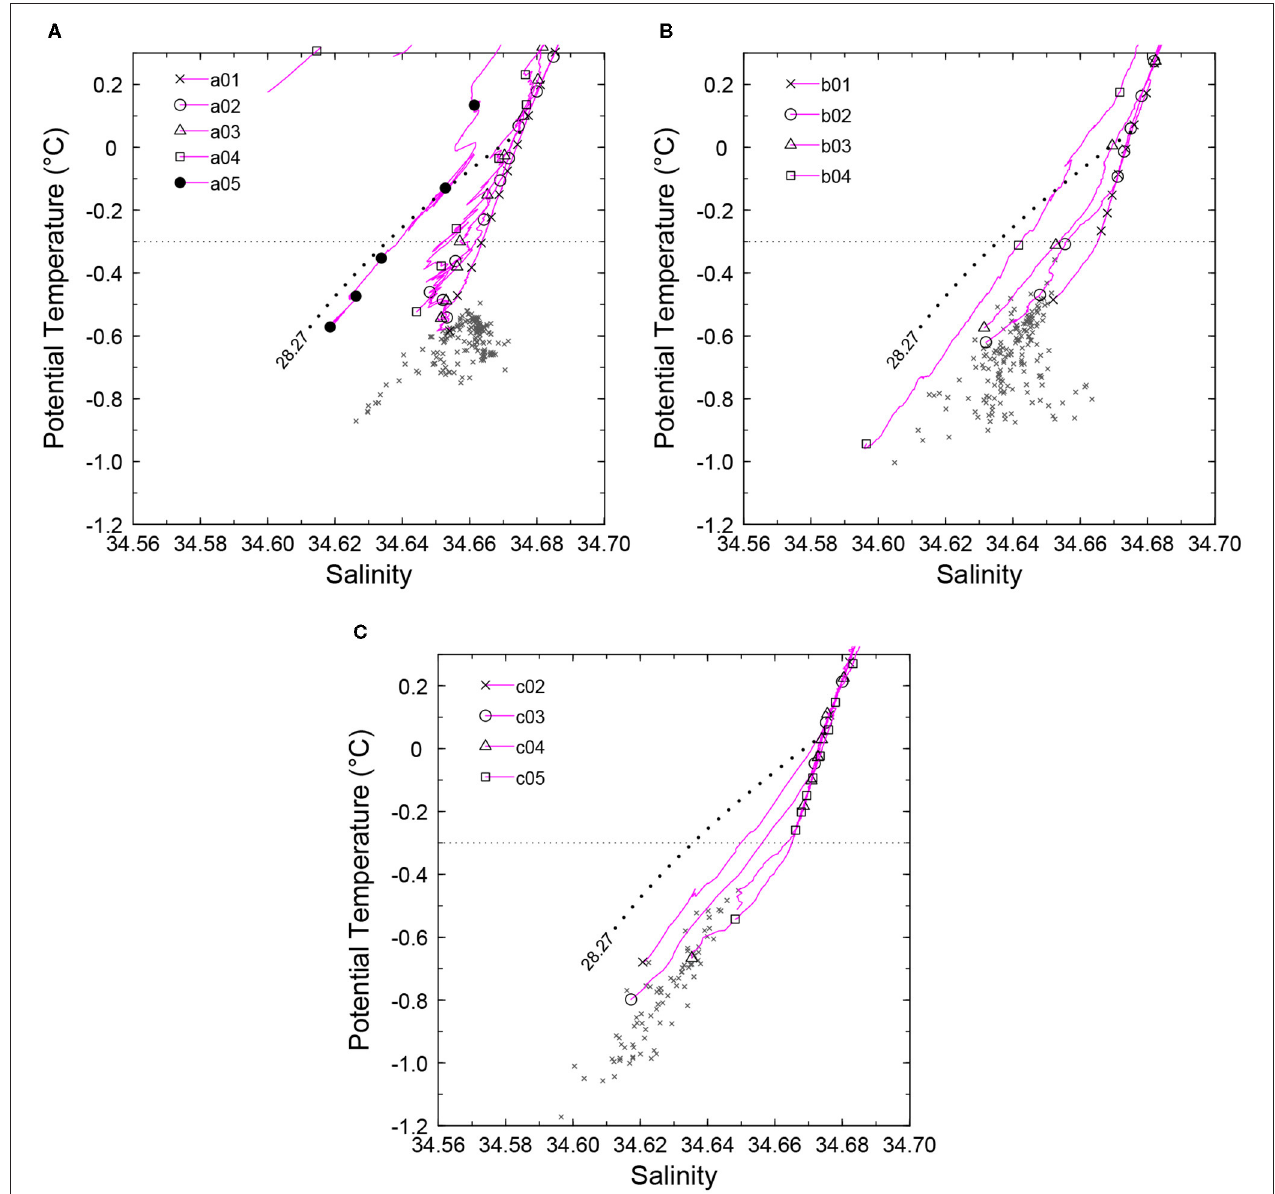
FIGURE 11 | Comparison of θ - S diagrams for moorings and CTD measurement. The gray crosses in (A,B) indicate data for the deepest CT sensors at moorings M1 and M3 in periods P3 and P4, respectively. The gray crosses in (C) indicate data for the deepest CT sensors at moorings M4 in period P4. Magenta lines with symbols indicate θ - S curves for CTD stations (A) a01–a05, (B) b01–b04, and (C) c02–c05. Symbols are plotted at 200 m intervals, starting from the bottom for CTD measurement. The dotted horizontal line indicates θ = − 0.3 ◦